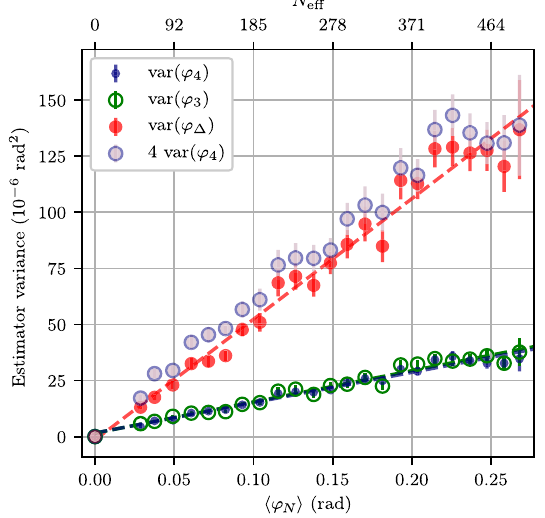
FIG. 2. Noise scaling of the atomic population estimators. Green and blue symbols are variances of φ 4 and φ 3 , red filled circles show the variance of φ Δ , rose circles show variance of φ 4 scaled by a factor of 4. Error bars are statistical, dashed lines are linear fits to the data of same color. The top x axis shows the inferred effective atom number N . Data were taken under eff similar conditions as in Fig.